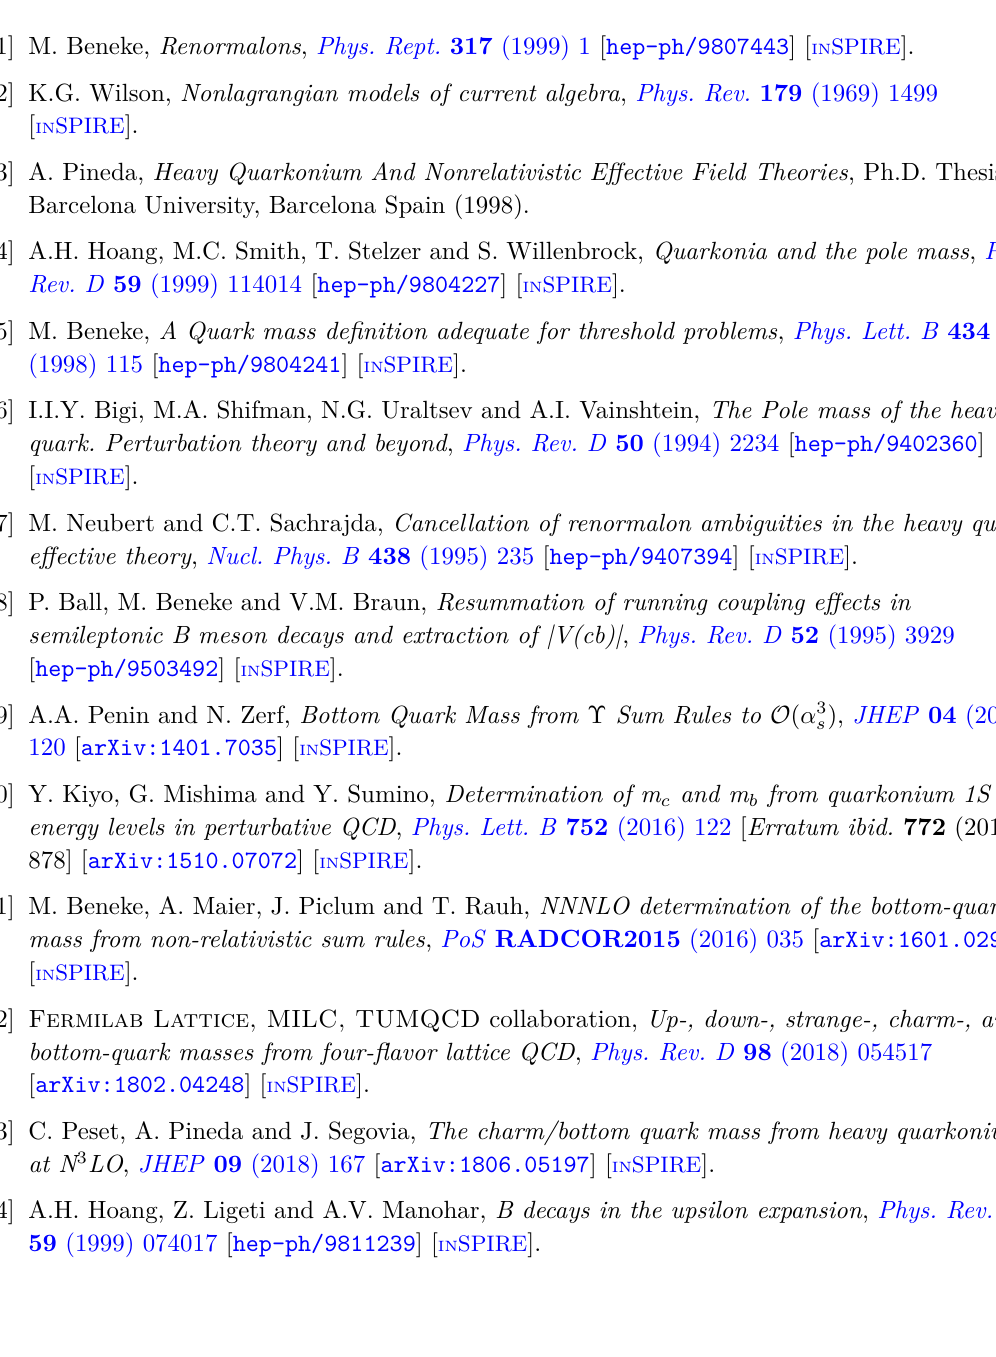
( Q ) by expanding it in Λ 2 /Q 2 or pow QCD